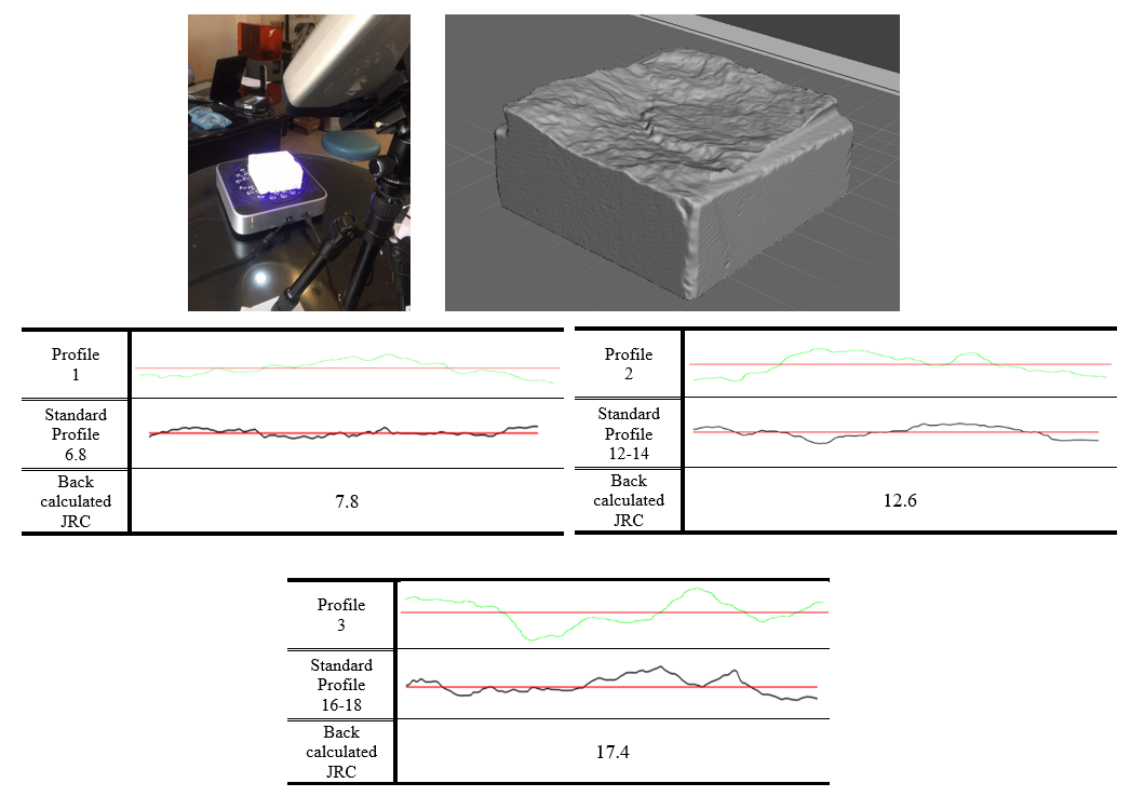
Figure 2. Digitizing replicas’ surface profiles and determining their JRC through visual comparison with Barton’s standard profiles and back-calculation after direct shear testing on non—grouted joints.